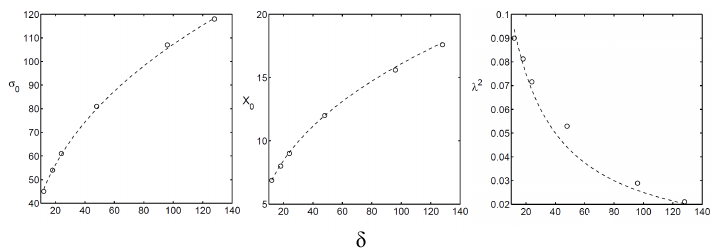
Fig. 3. Scaling of the parameters vs. the scale in the modified Castaing model used for the fits of P(δv || ,δ) shown in Fig. 2 and given in Table 1. Circles denote the values used; dash curves are: σ 0 = 17 δ 0 . 4 ; X 0 = 2 . 55 δ 0 . 4 ; and λ 2 = 3 ./( 20 + δ) , respectively. In addition, a s ∼ constant, see Table 1.